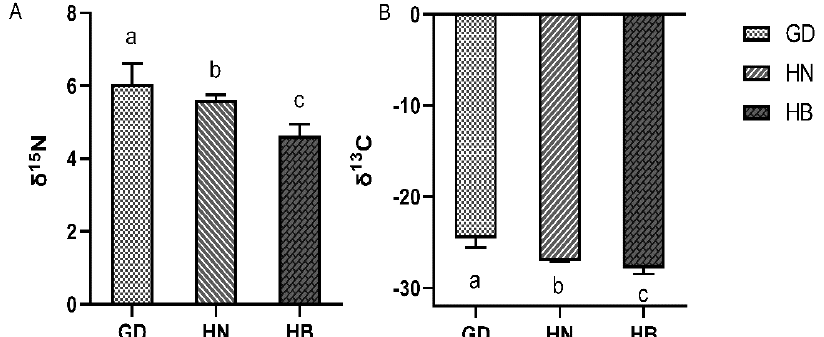
Figure 2. Stable isotope results from P. clarkii muscle samples. GD = Guangdong; HN = Hunan; HB = Hubei. δ 15 N results ( A ); δ 13 C results ( B ). δ 13 C and δ 15 N represent the stable isotope ratios. The different superscript lowercase letters (a, b, c) indicate a significant difference at p < 0.05 based on a one-way ANOVA and Duncan’s test.